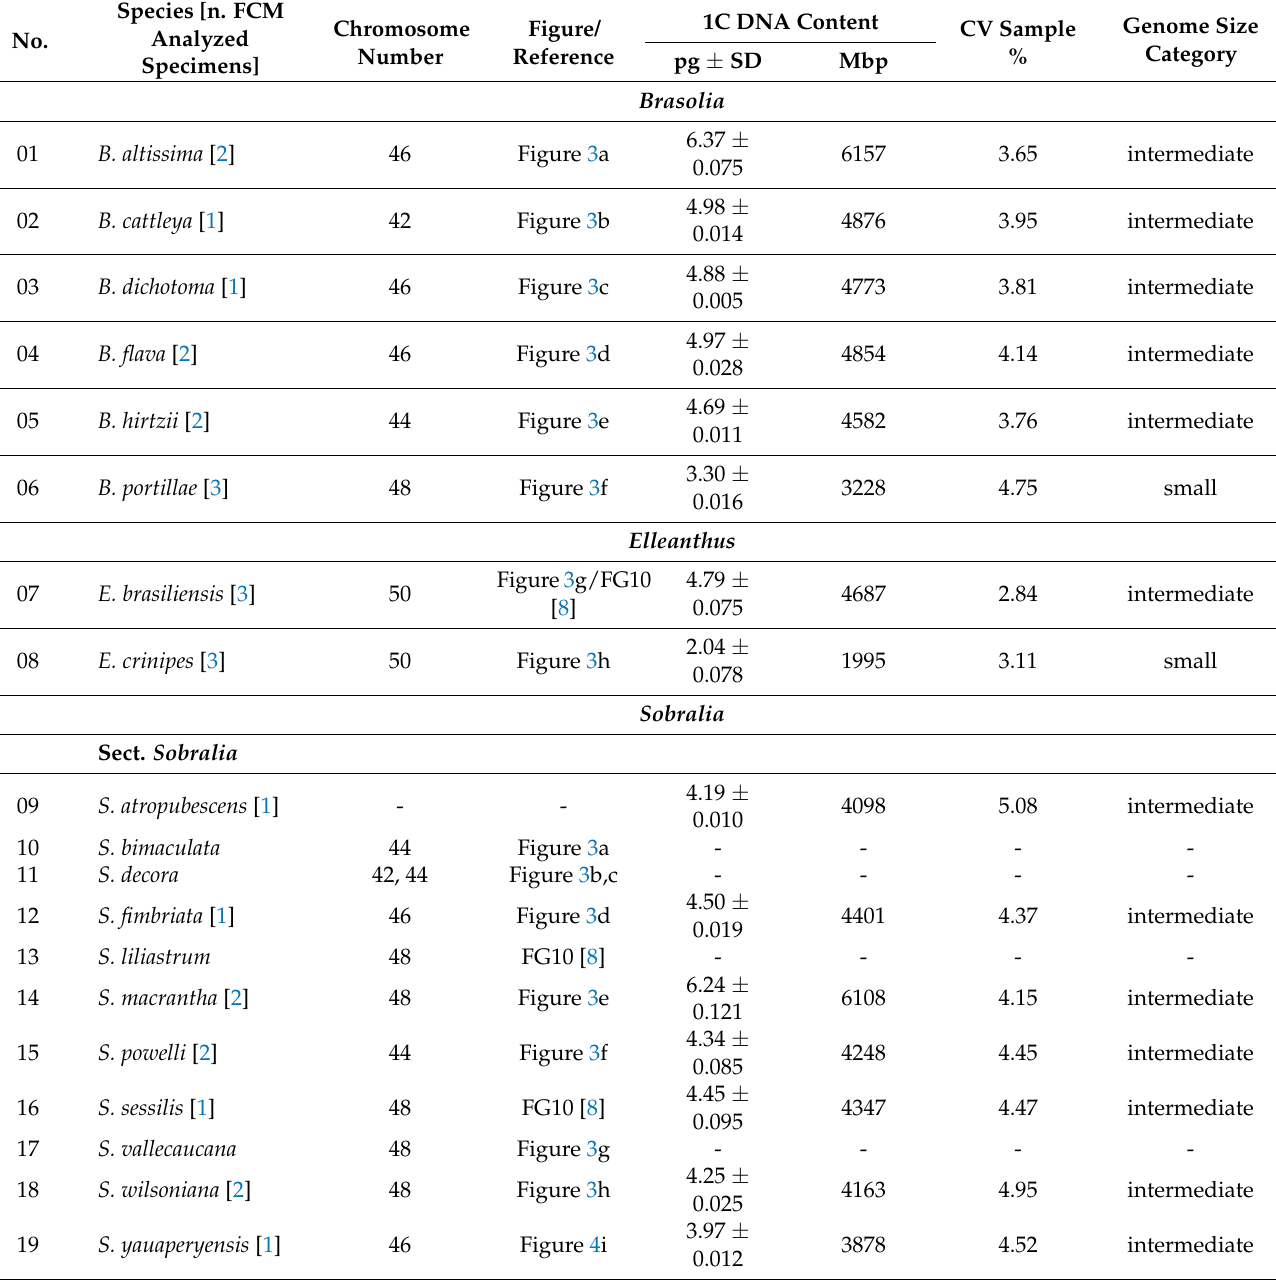
Table 1. Chromosome number and genome size in Sobralieae. The list of Brasolia , Elleanthus , and Sobralia species analyzed here and published on the literature is presented. For each species, the determined chromosome number is presented followed by its figure in text or reference on the literature. For each species analyzed here, the number of analyzed specimens in FCM is indicated in brackets. The genome size is presented in pg, followed by its standard deviation (SD), and Mega base-pairs (Mbp). The genome size (the 1C-value) is given in pg ± SD (Standard Deviation) and Mbp (Mega base-pairs). For each 1C-value, the sample Coefficient of Variation (CV) is presented and the genome size is classified according Soltis et al.